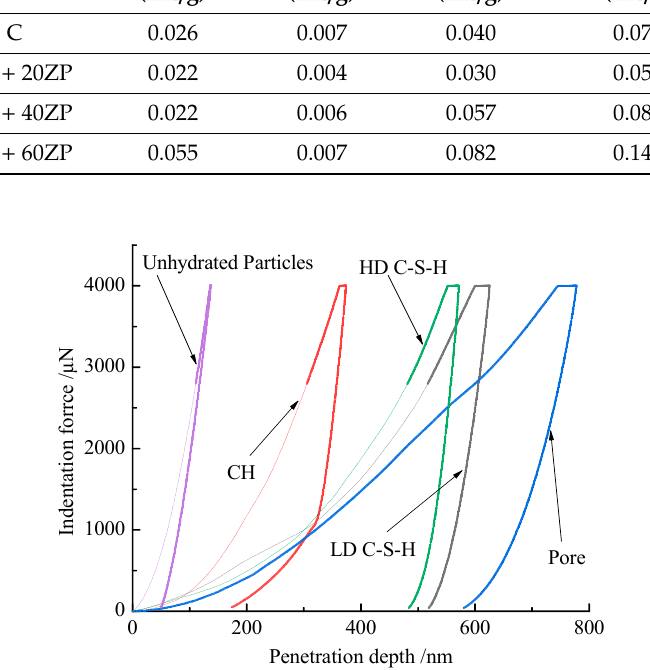
Figure 10. Typical load-penetration depth curves in concrete matrix.